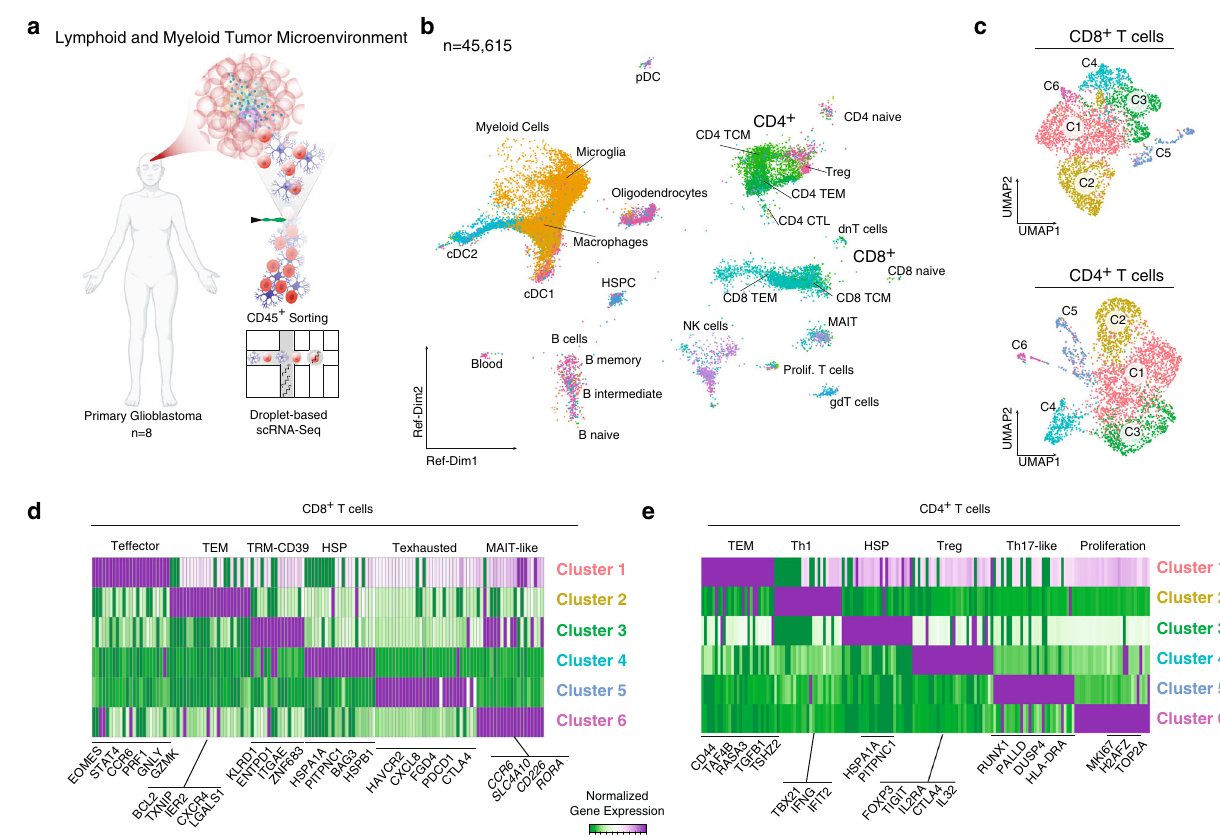
Fig. 1 Cluster and cell type analysis of lymphoid cells in glioblastomas. a Illustration of the work fl ow: tissue specimens for scRNA-sequencing were obtained from eight donors diagnosed with primary glioblastoma. b Weighted mutual neighbor (WNN) data integration and dimensional reduction using reference UMAP, was used to determine the cell types. c Isolated and clustered CD8 + (upper UMAP) and CD4 + (bottom UMAP) cells are indicated by colors. d , e Heatmaps of marker genes (top 30) across clusters from CD8 + cells (right panel) and CD4 + cells (left panel). T effector T effector cells, TEM